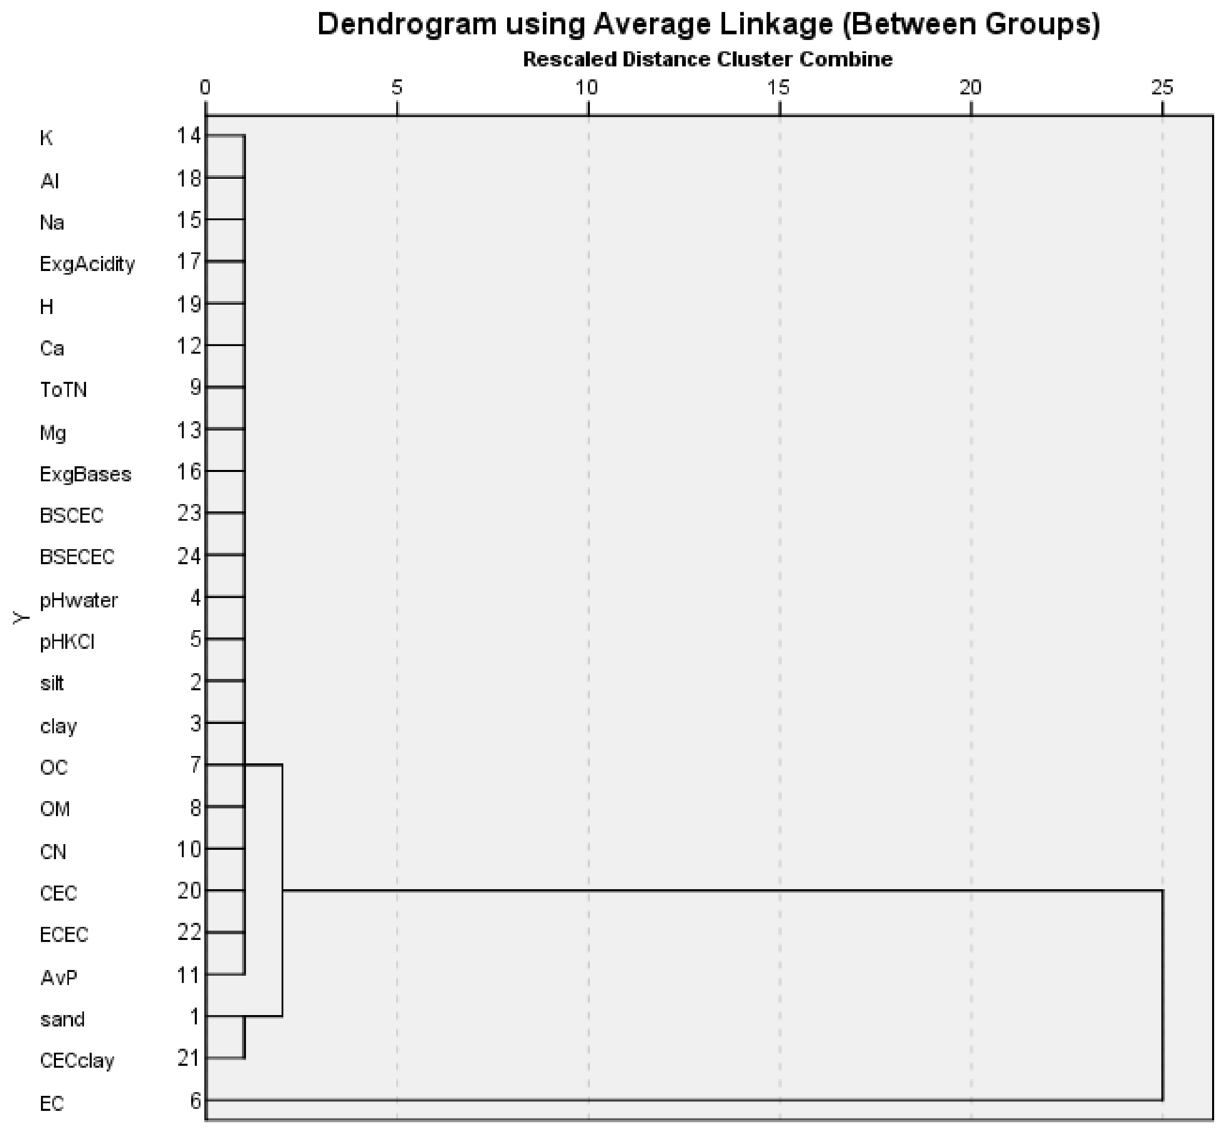
Figure 5. Dendrogram obtained from soil analyses in the freshwater wetlands of Bamenda